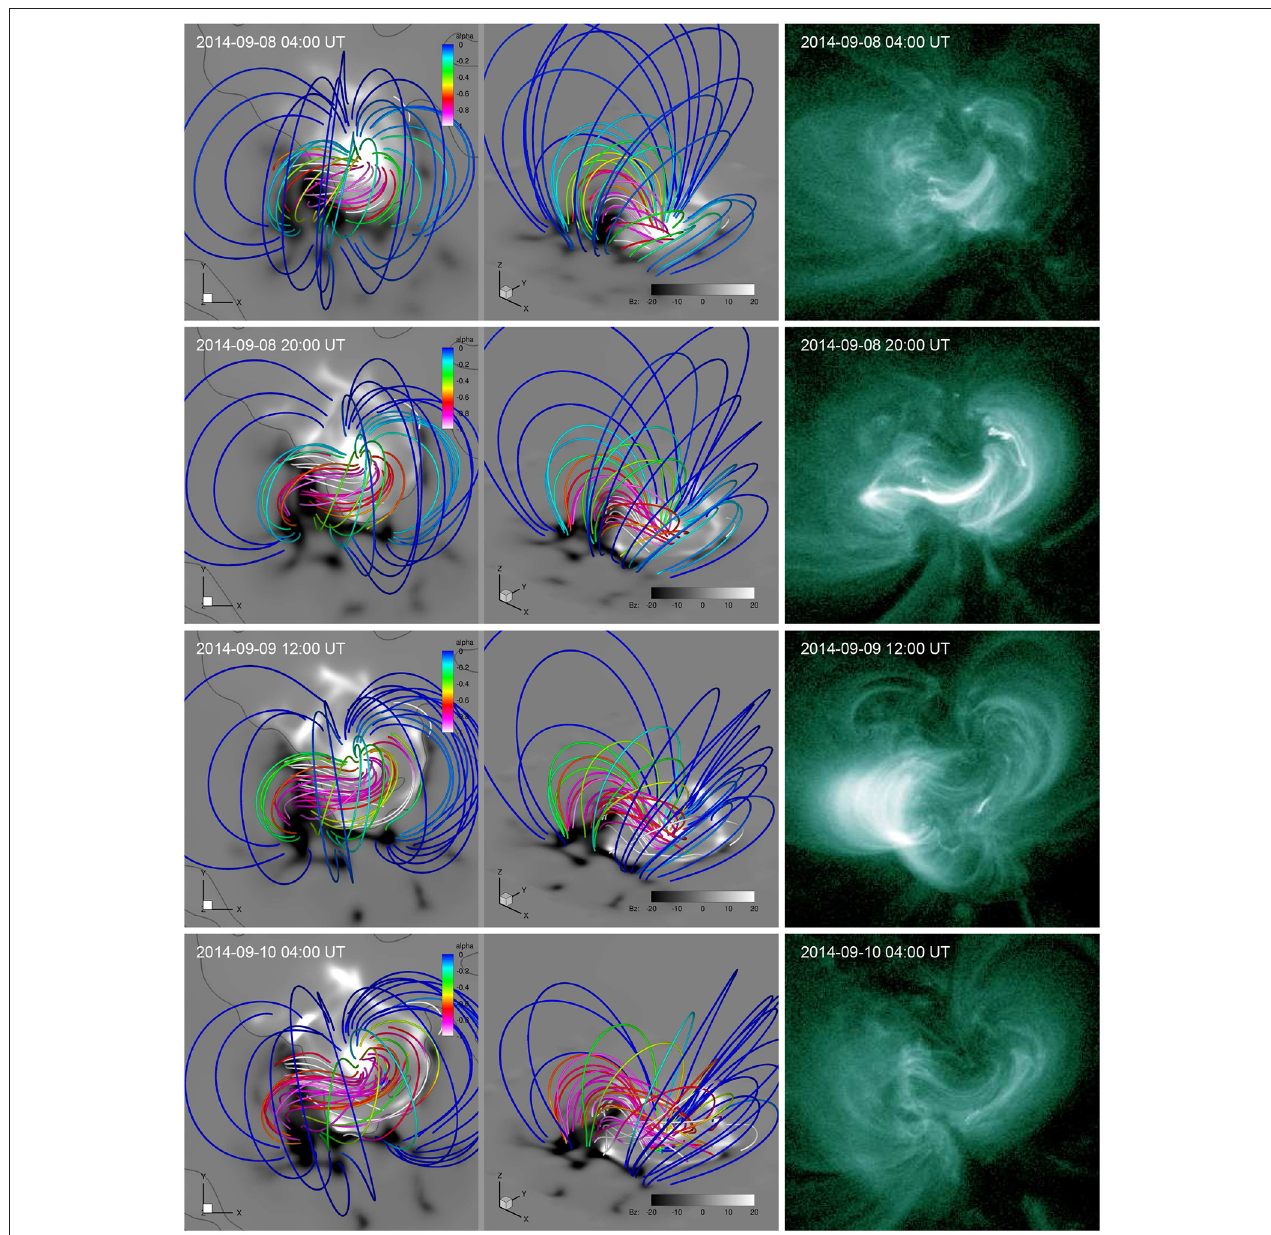
FIGURE 7 | Evolution of the magnetic field lines (shown in different view angles in the left and middle columns) and their comparison with observed coronal loops observed in EUV wavelength of 94 Å by SDO/AIA (right column). The field lines are shown in the same format in Figure 3 . An animation of the magnetic field evolution is attached for this